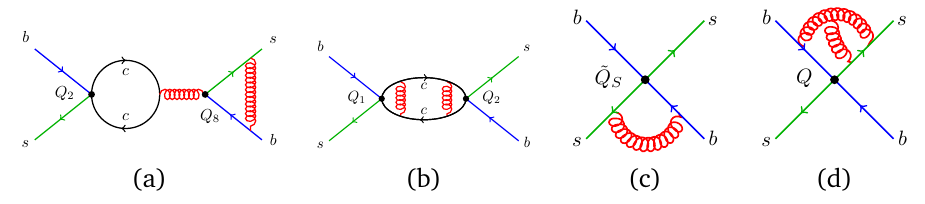
Figure 1: Sample ∆ B = 1 and ∆ B = 2 Feynman diagrams contributing to the process b ¯ s → ¯ bs . Here (a) and (b) represent ∆ B = 1 contributions from Q × Q and Q (three loops), while (c) and (d) show one- and two-loop matrix elements 1 2 of ∆ B = 2 operators ˜ Q and Q s